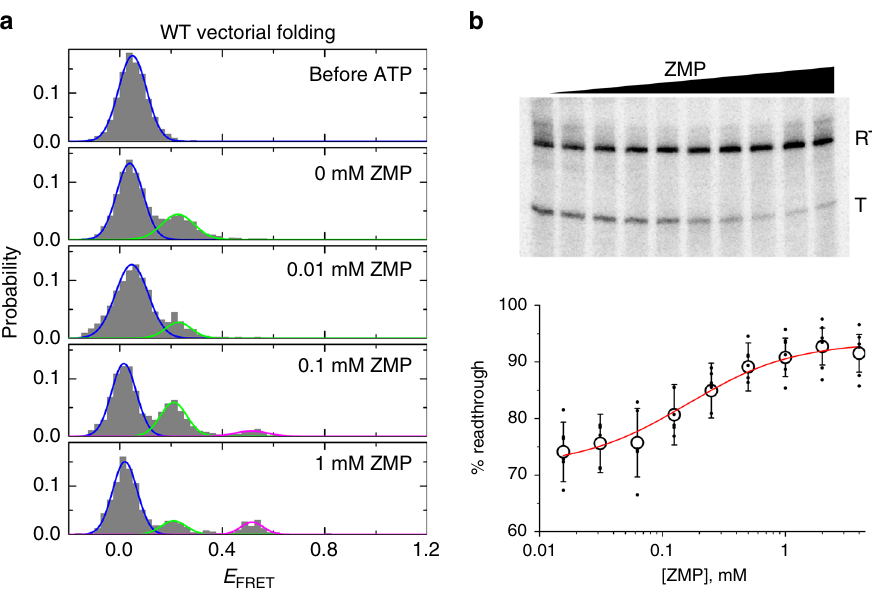
Fig. 3 Single-molecule helicase-catalyzed unwinding experiments of the ZTP riboswitch. a The E FRET histograms of the WT heteroduplex before and after ATP addition at different ZMP concentrations using VF with Rep-X. Gaussian fi tting with global constraints was used to determine the relative populations of the initial heteroduplex (blue), terminator (green), and ZMP-bound aptamer (magenta) conformations. b Bulk single-round transcription termination experiments of ZTP riboswitch are shown in the presence of 0.2 mM NTPs and varying amounts of ZMP (0 – 4 mM). RT and T stand for the readthrough and terminated products, respectively. Quanti fi cation of all experiments under these conditions is shown below (mean ± standard deviation (s.d.) shown as large open circles, n = 6 independent experiments shown as small circles).